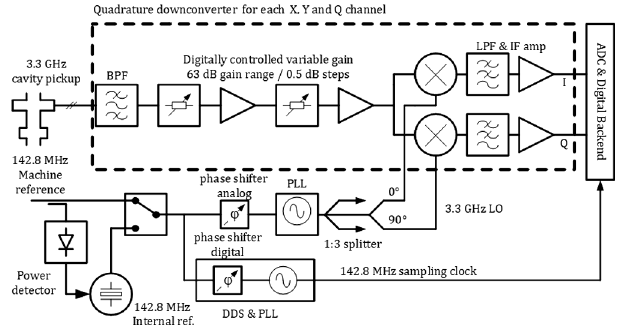
FIG. 8. Simplified block diagram of low-Q CBPM rf front-end electronics, showing only one of its three input channels (one reference and two position signal channels).